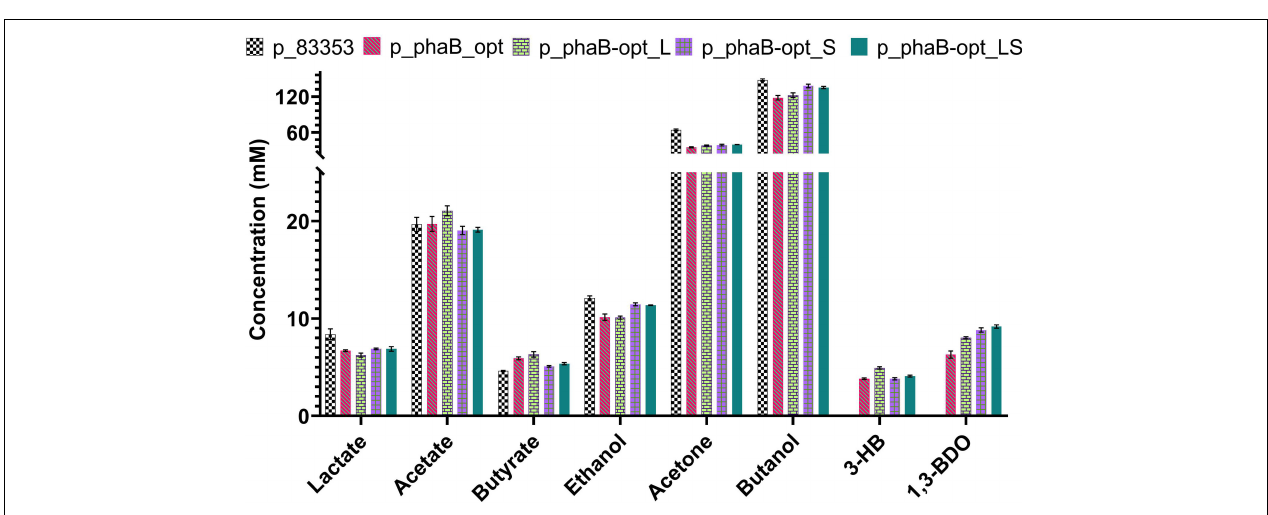
FIGURE 4 | Comparison of product spectrum C. saccharoperbutylacetonicum cells carrying the empty plasmid control p_83353 and codon optimised phaB and its derivatives with point mutations after 48 h. From left to right for each product p_83353 in chequerboard, p_ phaB _opt in red diagonal lines, p _phaB -opt_L in green bricks, p _phaB -opt_S in purple squares and p_phaB-opt_LS in green dots. Error-bars represent